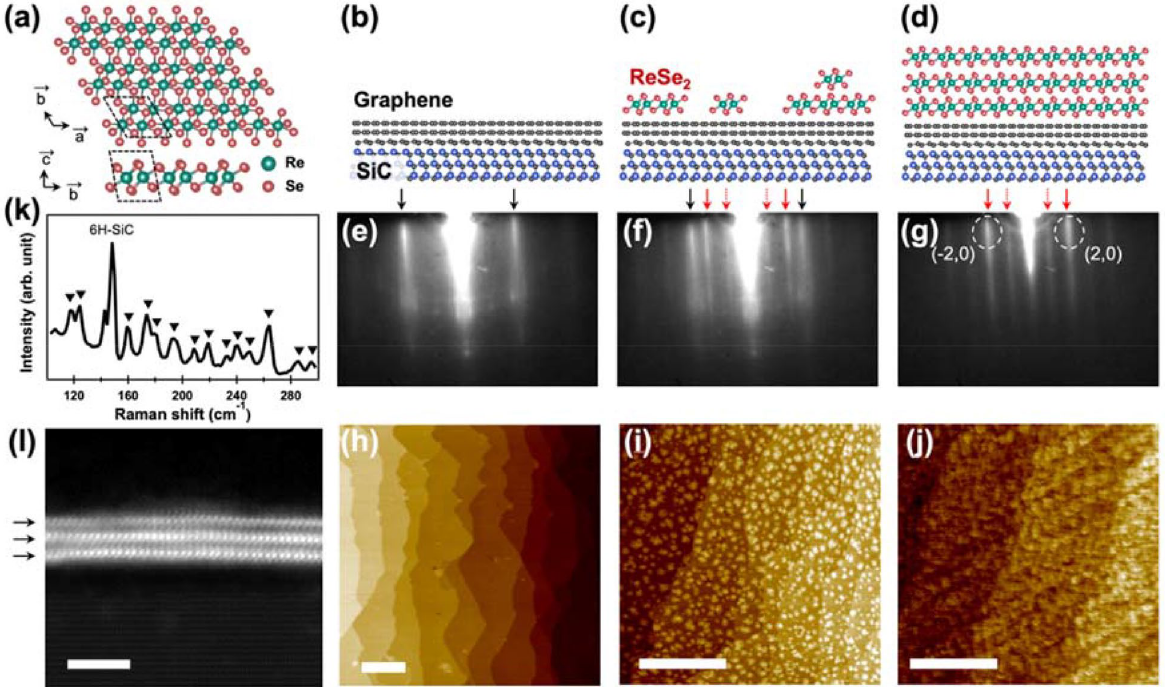
Fig. 2 Growth and characterization of ReSe 2 thin films. a Crystal structures of 1 T’ ReSe 2 . b – d Schematic models of the graphene substrate and ReSe 2 thin films with 0.3UC and 3UC. e – g RHEED images and h – j AFM images of the ReSe 2 thin film for different growth times (0, 4, and 62 min). The black and red arrows in the RHEED images indicate the bilayer graphene substrate and ReSe 2 diffraction streak, respectively. k Raman spectrum and l HAADF STEM image of the 3UC ReSe 2 film. Scale bars in the AFM and STEM images are 500 nm and 3 nm,